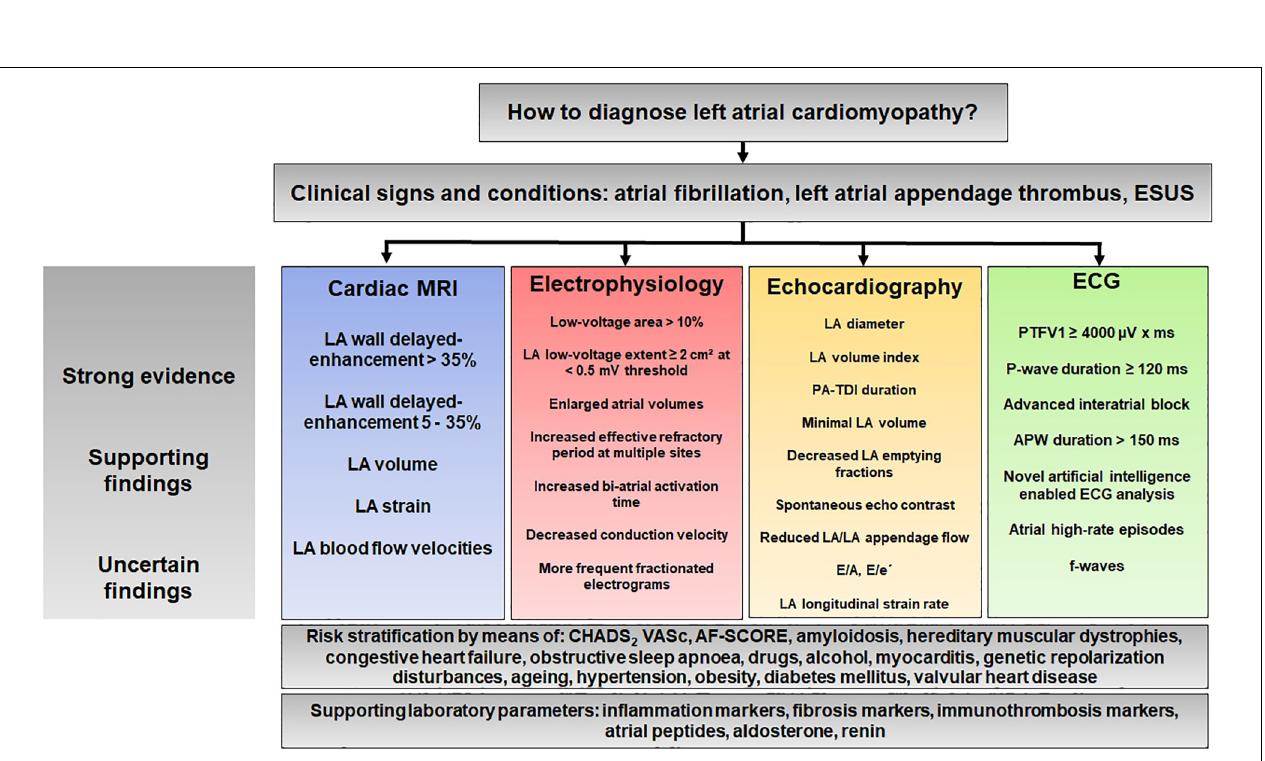
FIGURE 8 | Proposal for a diagnostic algorithm for atrial cardiomyopathy based on the results of previous studies. APW, amplified P-wave; ESUS, embolic stroke of undetermined source; LA, left atrium/left atrial; PA-TDI, total atrial conduction time assessed by tissue doppler imaging; PTFV1; P-wave terminal force in lead V1.